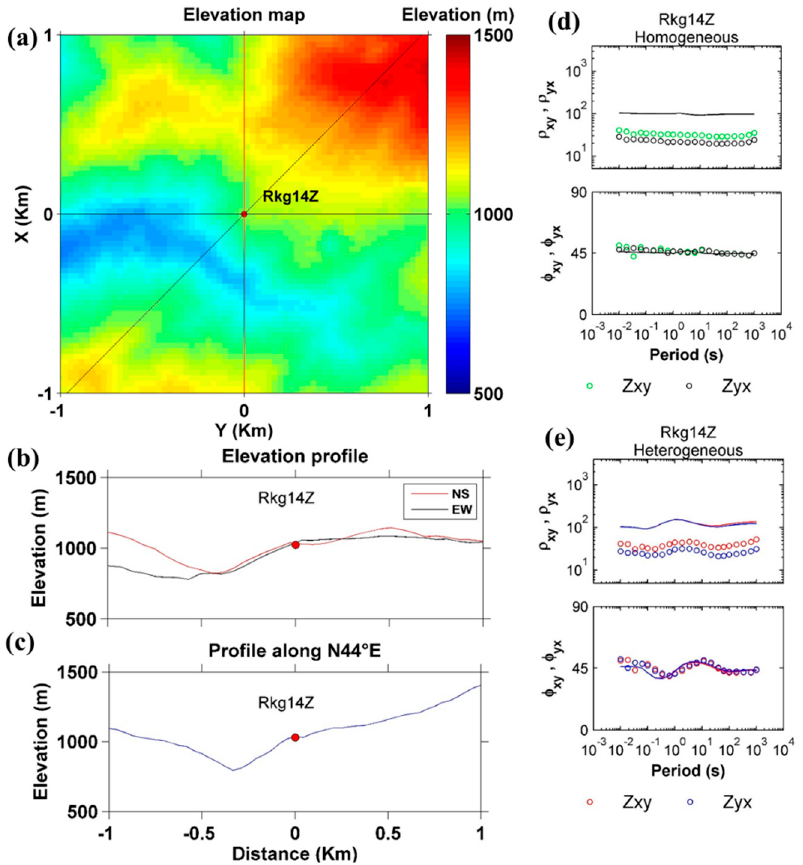
Figure 9. ( a ) The elevation map around site 14. ( b ) Elevation profile along the NS, EW and the direction of maximum elevation change ( c ). ( d ) The comparison of MT response of off-diagonal components generated by ( d ) homogeneous half-space model and ( e ) Heterogeneous model. Site 19 is located in the outer LH region at an altitude of 1843 m. The elevation and slope vary from 1663 m to 2209 m and − 19° to +17°, respectively, around this site. The maximum variations in the elevation values are along N 44° E. Since the site is located at a hillslope, the response is dominantly influenced by a hill. The off-diagonal components responses for flat surface and topographic models are shown in Figure 10d. The downward shift of the response’s amplitude suggests that the topographic effect is galvanic in nature.